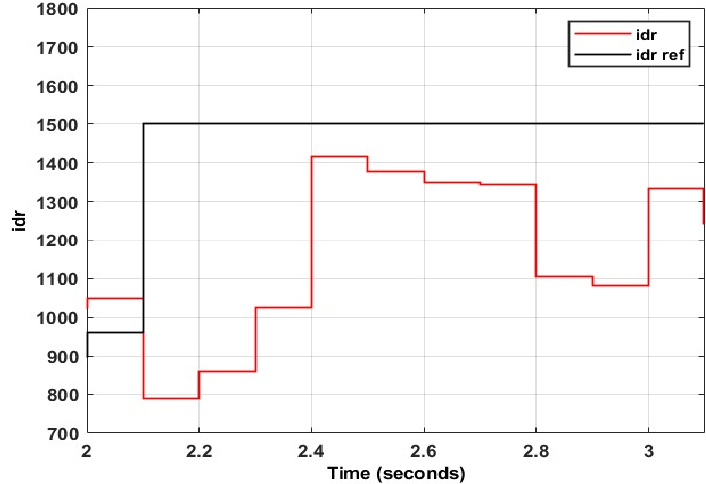
Figure 56. Rotor direct axis current average using LQR at 90% dip.